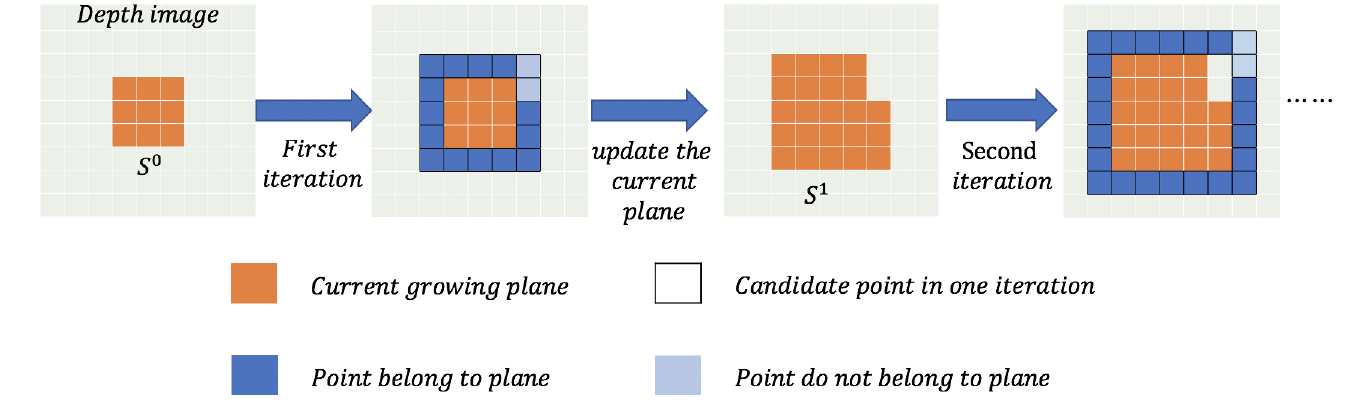
Figure 10. Iteration growing process from a 3 × 3 seed